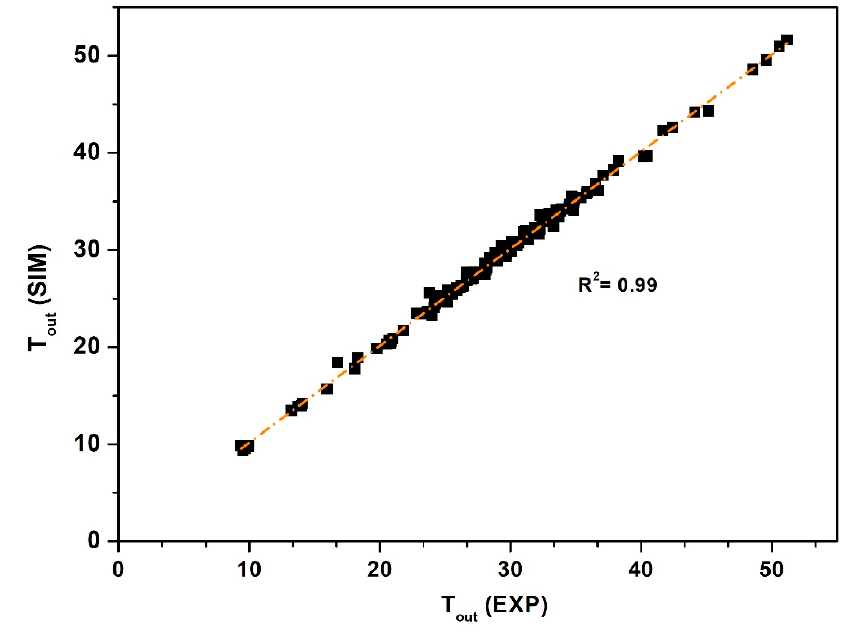
Figure 5. Comparison of simulated and experimentally measured temperatures for fluid on the outlet of the collector in the ASTF.